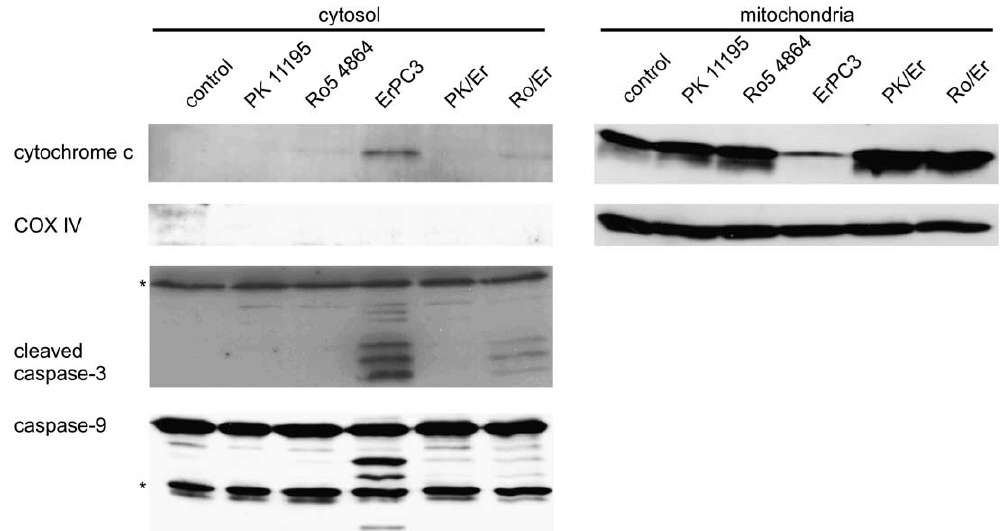
Fig. 7. Effects of TSPO ligands on ErPC3-induced cytochrome c release, and caspase-3 and -9 processing. U118MG cells were incubated for 12 h with 50 µM of PK 11195 or Ro5 4864, or ErPC3 (15 µM), or ErPC3 in combination with either PK 11195 or Ro5 4864 (PK/Er, Ro/Er), or treated with vehicle (control). Caspase-3 and -9 expression, including their cleavage products, and cytochrome c release, were analysed by Western blot protein analysis. Probing with a COX IV-specific antibody served as quality control for cell separation. Co-treatments with PK11195 or Ro5 4864 nearly completely blocked the effects of ErPC3 on cytochrome c release, and caspase-3 and -9 processing. Abbreviations: PK, PK 11195; Ro, Ro5-4864; Er, ErPC3; ∗ unspecific